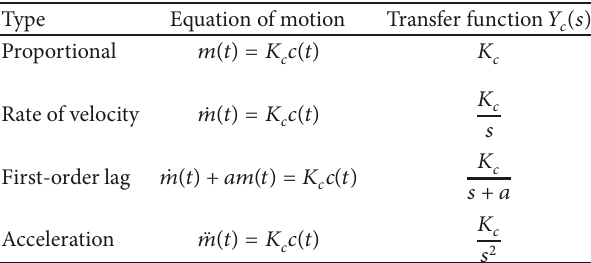
Table 4: Dynamics of controlled